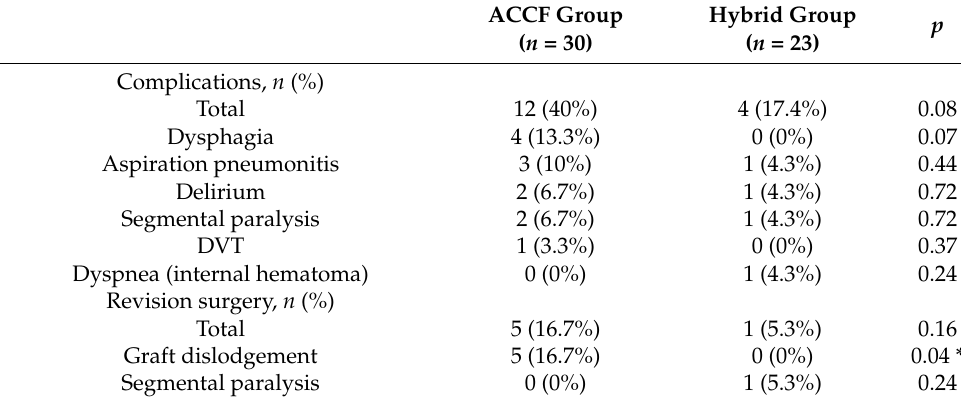
Table 3. Perioperative complications in the ACCF and hybrid